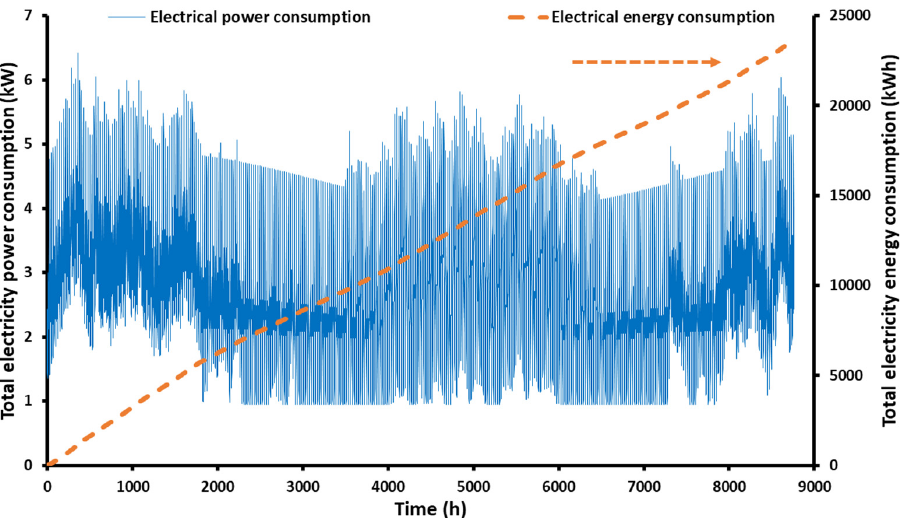
Figure 9. Variation in the total electricity demand in [kW] and the cumulative electricity demand in [kWh] of the studied building.